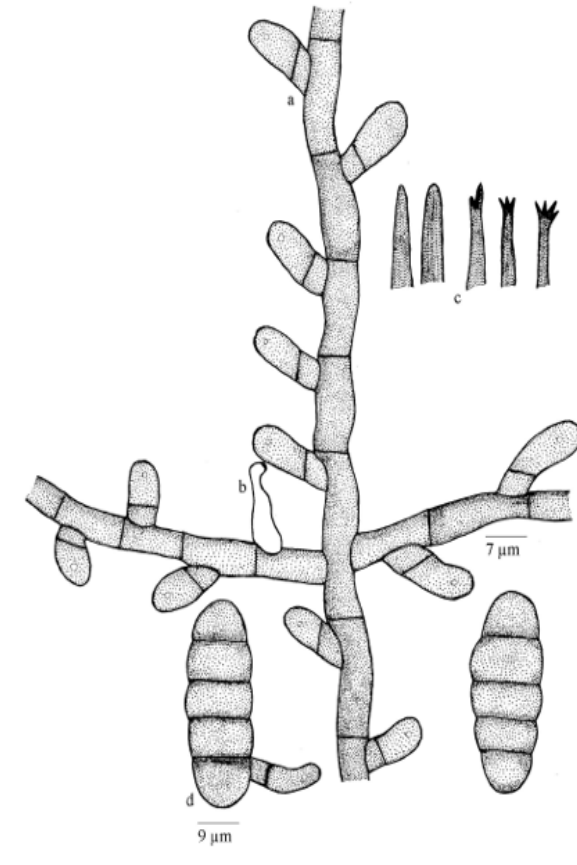
Figure 96. Meliola mangiferae a - Appressorium; b - Phialide; c - Apical portion of mycelial setae; d -